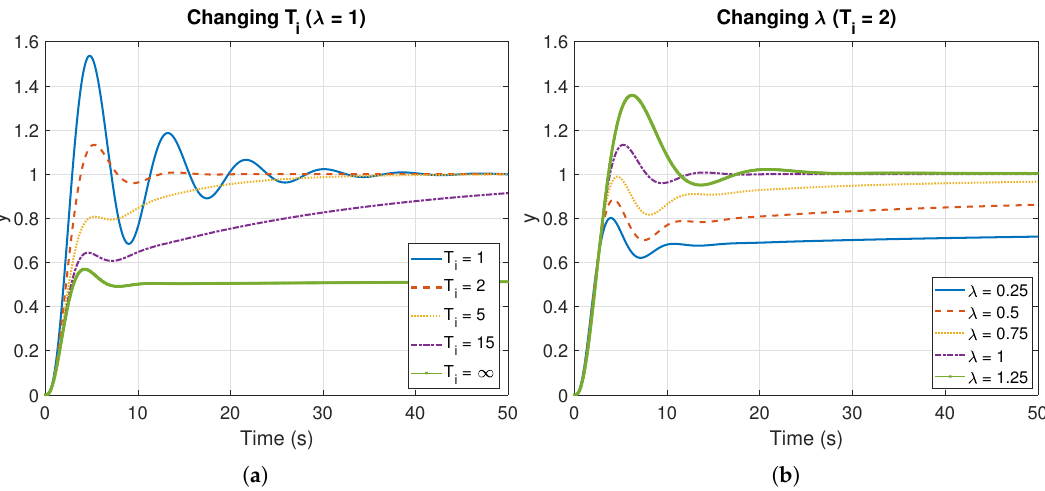
Figure 10. Step responses in closed-loop of system (17) controlled by fractional PI controller (18) when changing: ( a ) integral time constant T i ( K p = 1, λ = 1) ( b ) integration order λ ( K p = 1, T i =